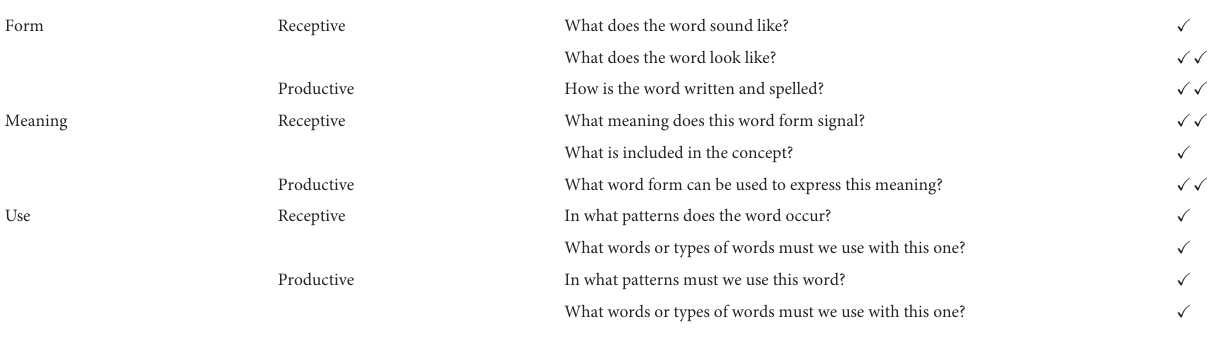
TABLE 1 Aspects of word knowledge dealt with by learning from word cards (Nation, 2013a, p.